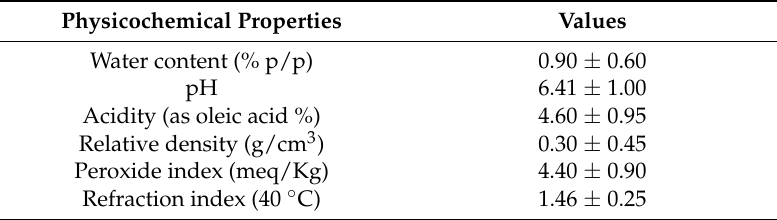
Table 2. Physicochemical properties of the fixed oils of the almond of O. speciosa .